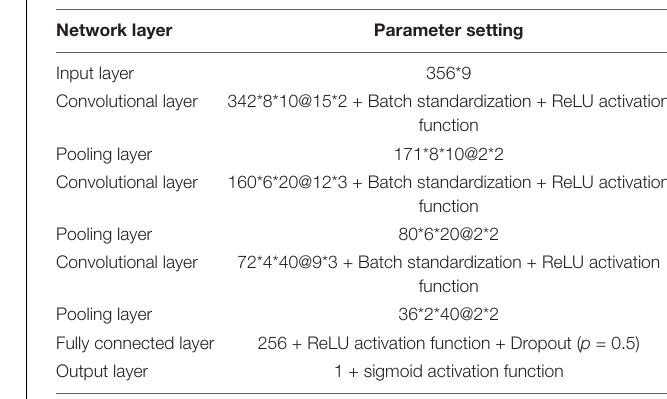
TABLE 3 | Convolution neural network (CNN) network parameter setting.